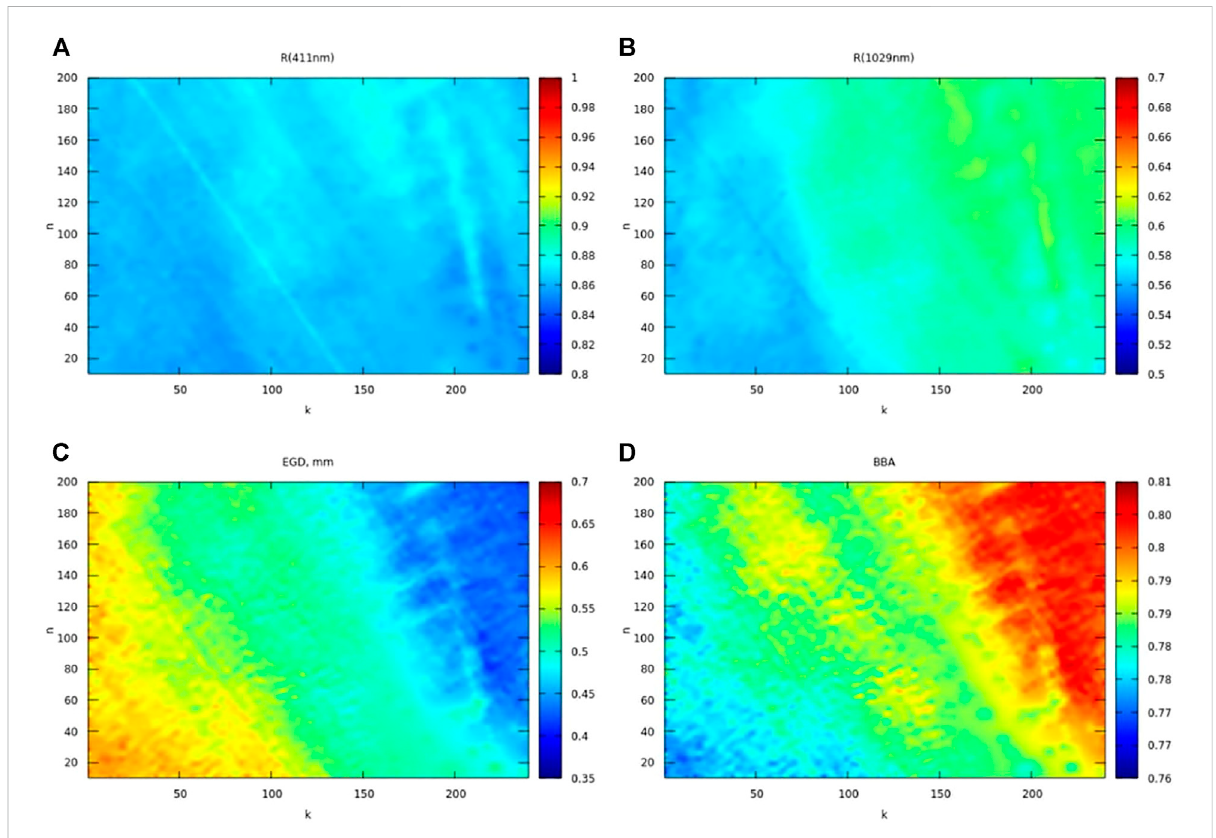
FIGURE 8 (A,B) : PRISMA re fl ectance at 411 and 1029 nm within the green box depicted in Figure 1. (C,D) : retrieved EGD and BBA from PRISMA images.